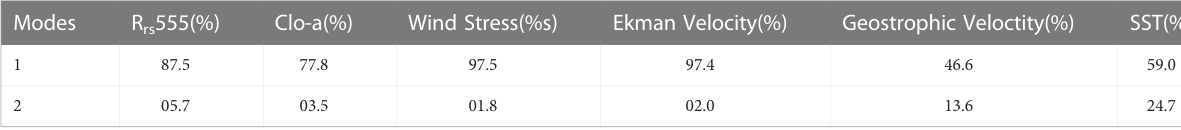
TABLE 1 Distribution of the total variation contained in the monthly data series.